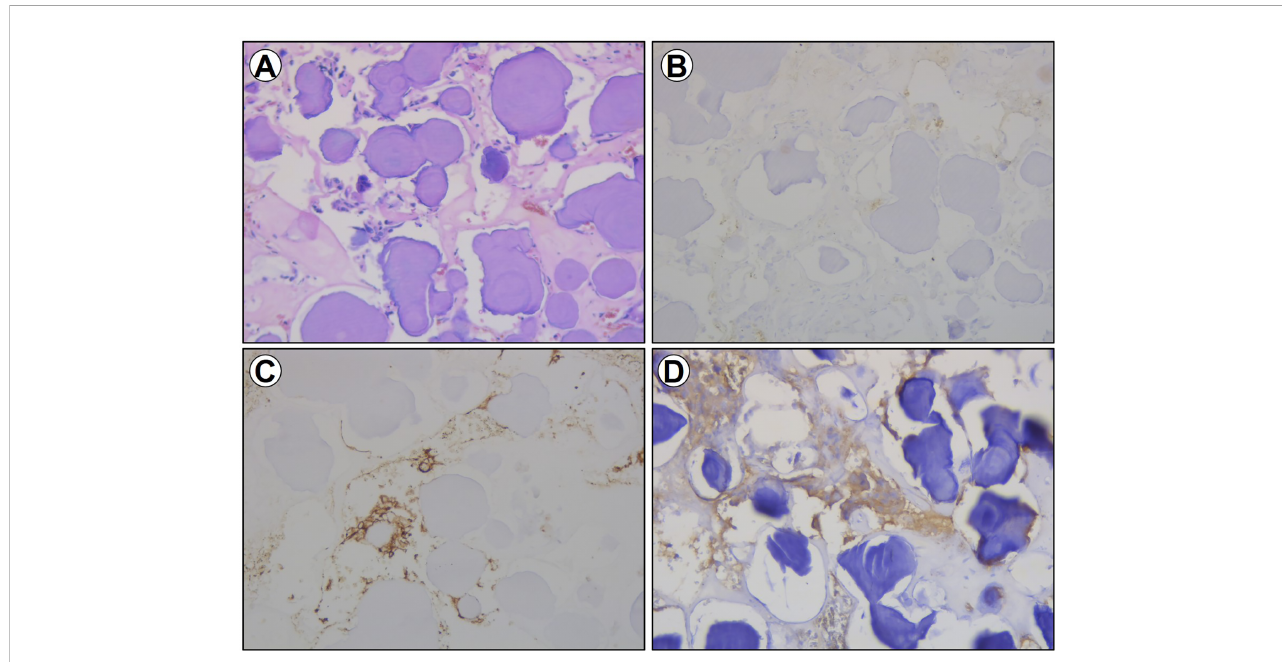
FIGURE 3 Section imaging data of the excised specimen. (A) HE staining for the excised specimen. (B) Immunohistochemical staining of TSH for the excised specimen. (C) Immunohistochemical staining of CD56 for the excised specimen. (D) Immunohistochemical staining of Syn for the excised